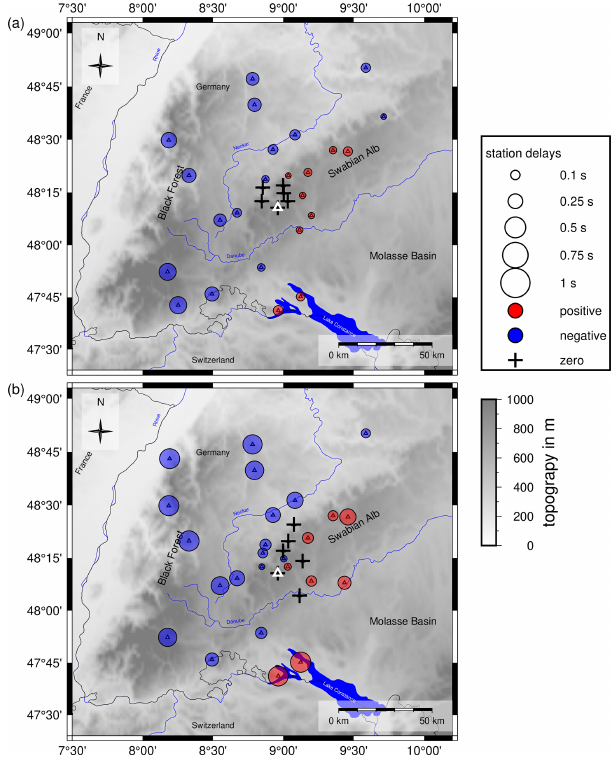
Figure 6. (a) Station delay times for the v p velocity model ASZ- mod1. (b) Station delay times for the v s velocity model ASZmod1. Blue circles represent negative station delay times, indicating areas with faster velocities than ASZmod1. Red circles illustrate positive station delay times, indicating slower velocities than ASZmod1. Crosses are stations with zero station delays. Only stations with more than five travel time picks are included. The small white tri- angle highlights reference station MSS. Topography is based on the ETOPO1 Global Relief Model (Amante and Eakins, 2009; NOAA National Geophysical Data Center,